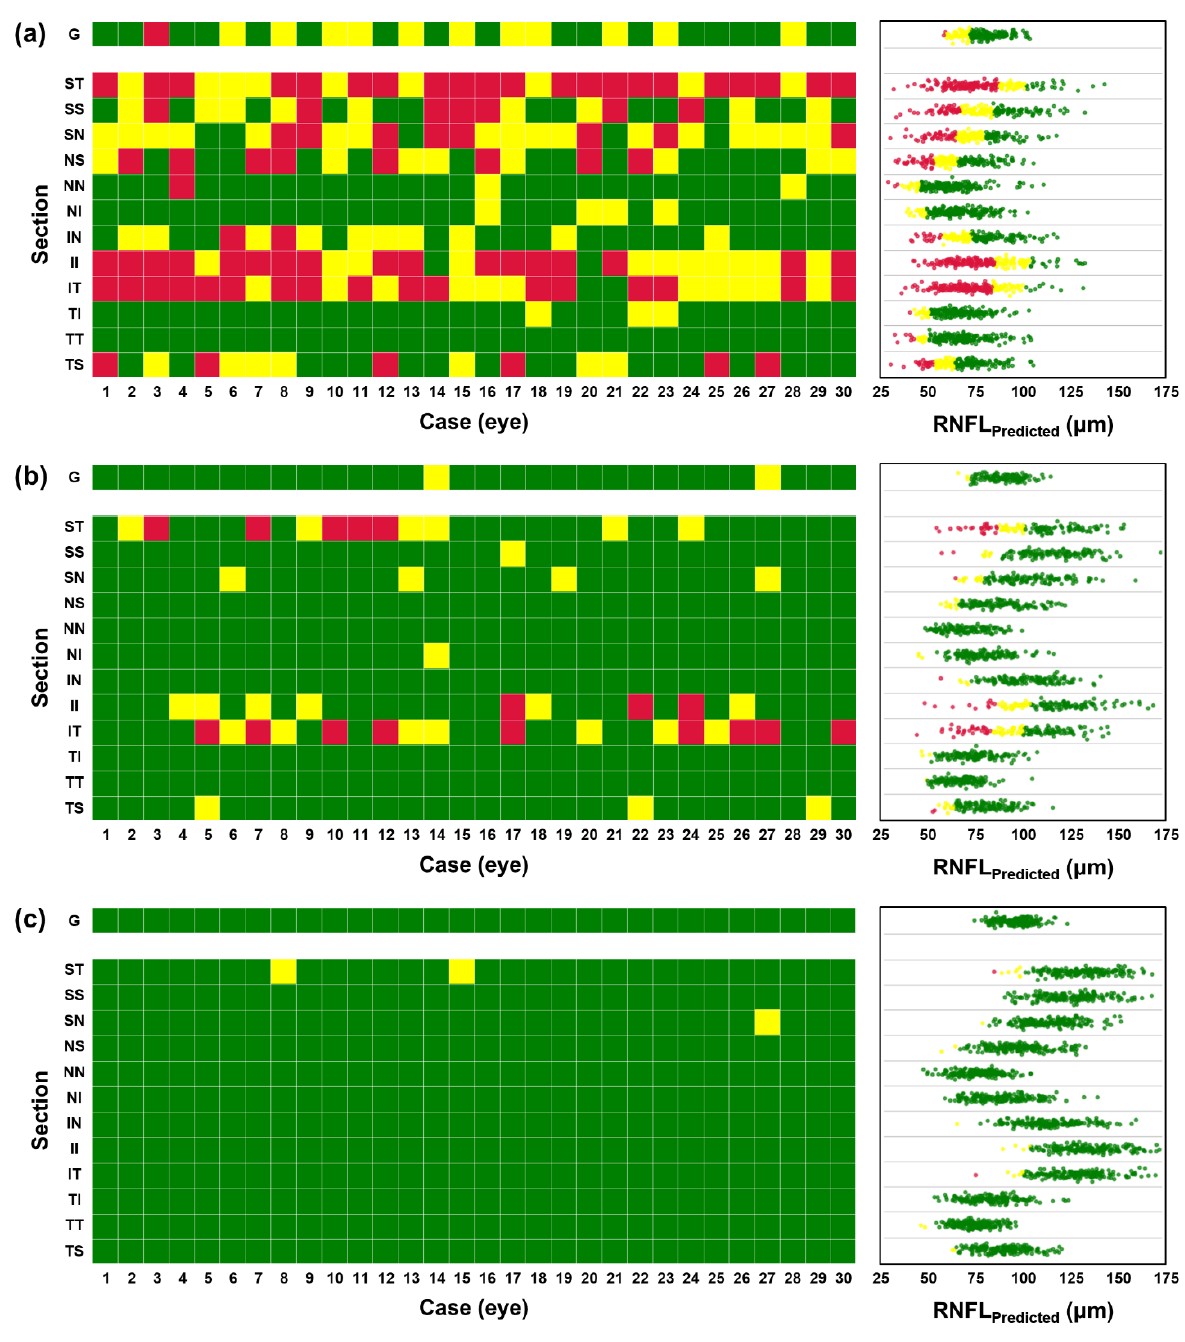
Figure 5. Prediction and categorization of RNFL for different patient groups; ( a ) glaucoma (N = 61, 210 cases), ( b ) suspicious (N = 93, 103 cases), and ( c ) healthy (N = 124, 167 cases) patients. The colored tiles showing the categorization of RNFL thinning level from a randomly selected 30 eyes and scatters on the right side represent all estimated RNFL values in ( µ m) with categorized color. Each row indicates regions from the global (G) and 12 regional subsections (from ST to